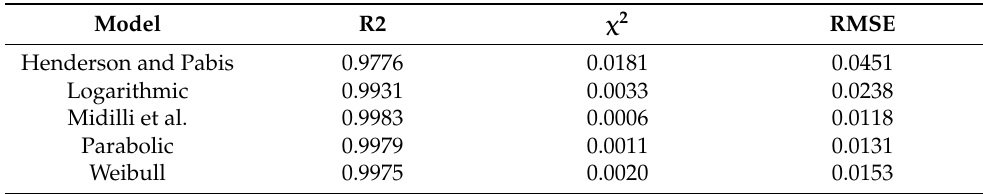
Table 2. Statistical analysis data of the thin-layer drying model for sludge drying.